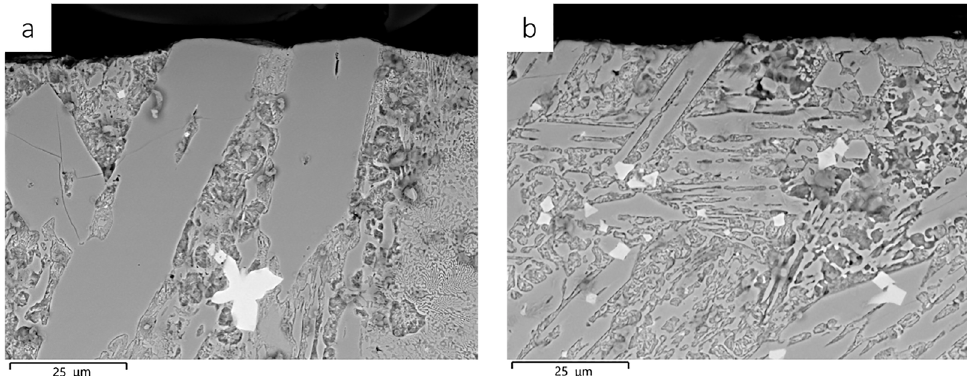
Figure 12. BSE-SEM micrographs of the cross-sectioned erosion crater: ( a ) 30 min of erosion, ( b ) 60 min of erosion.